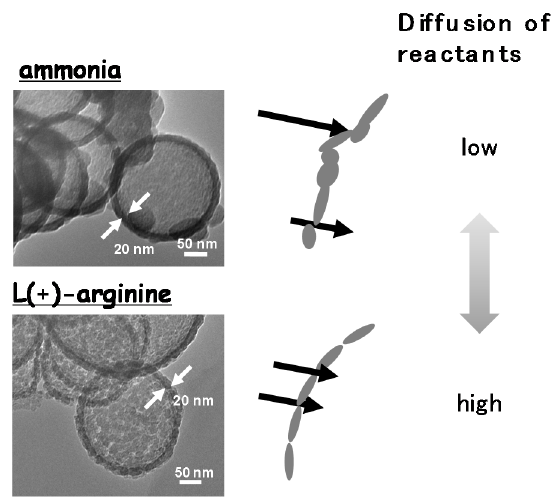
Figure 4. Difference in morphology of hollow silica-alumina composite spheres prepared using ammonia and L(+)-arginine